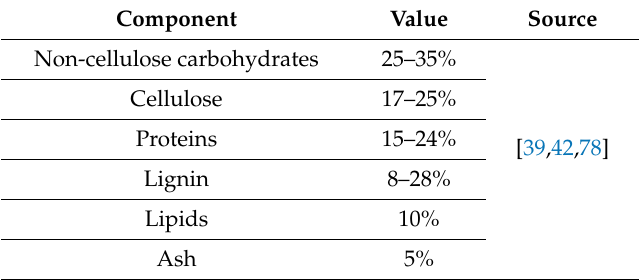
Table 3. General chemical composition of spent brewer’s yeast according to di ff erent